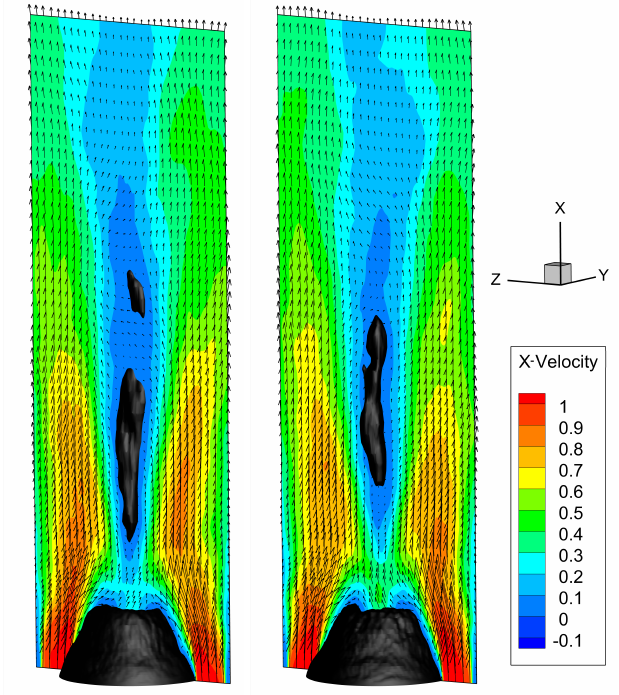
Figure 9. Reconstruction of the axial velocity fields ( m / s ) by 3D ROM using the second mode pair ( St = 0.0729), with a black isosurface of zero axial velocity and the velocity vectors shown. Left : Reconstruction with the minimal temporal coefficient. Right : Reconstruction with the maximal temporal coefficient.